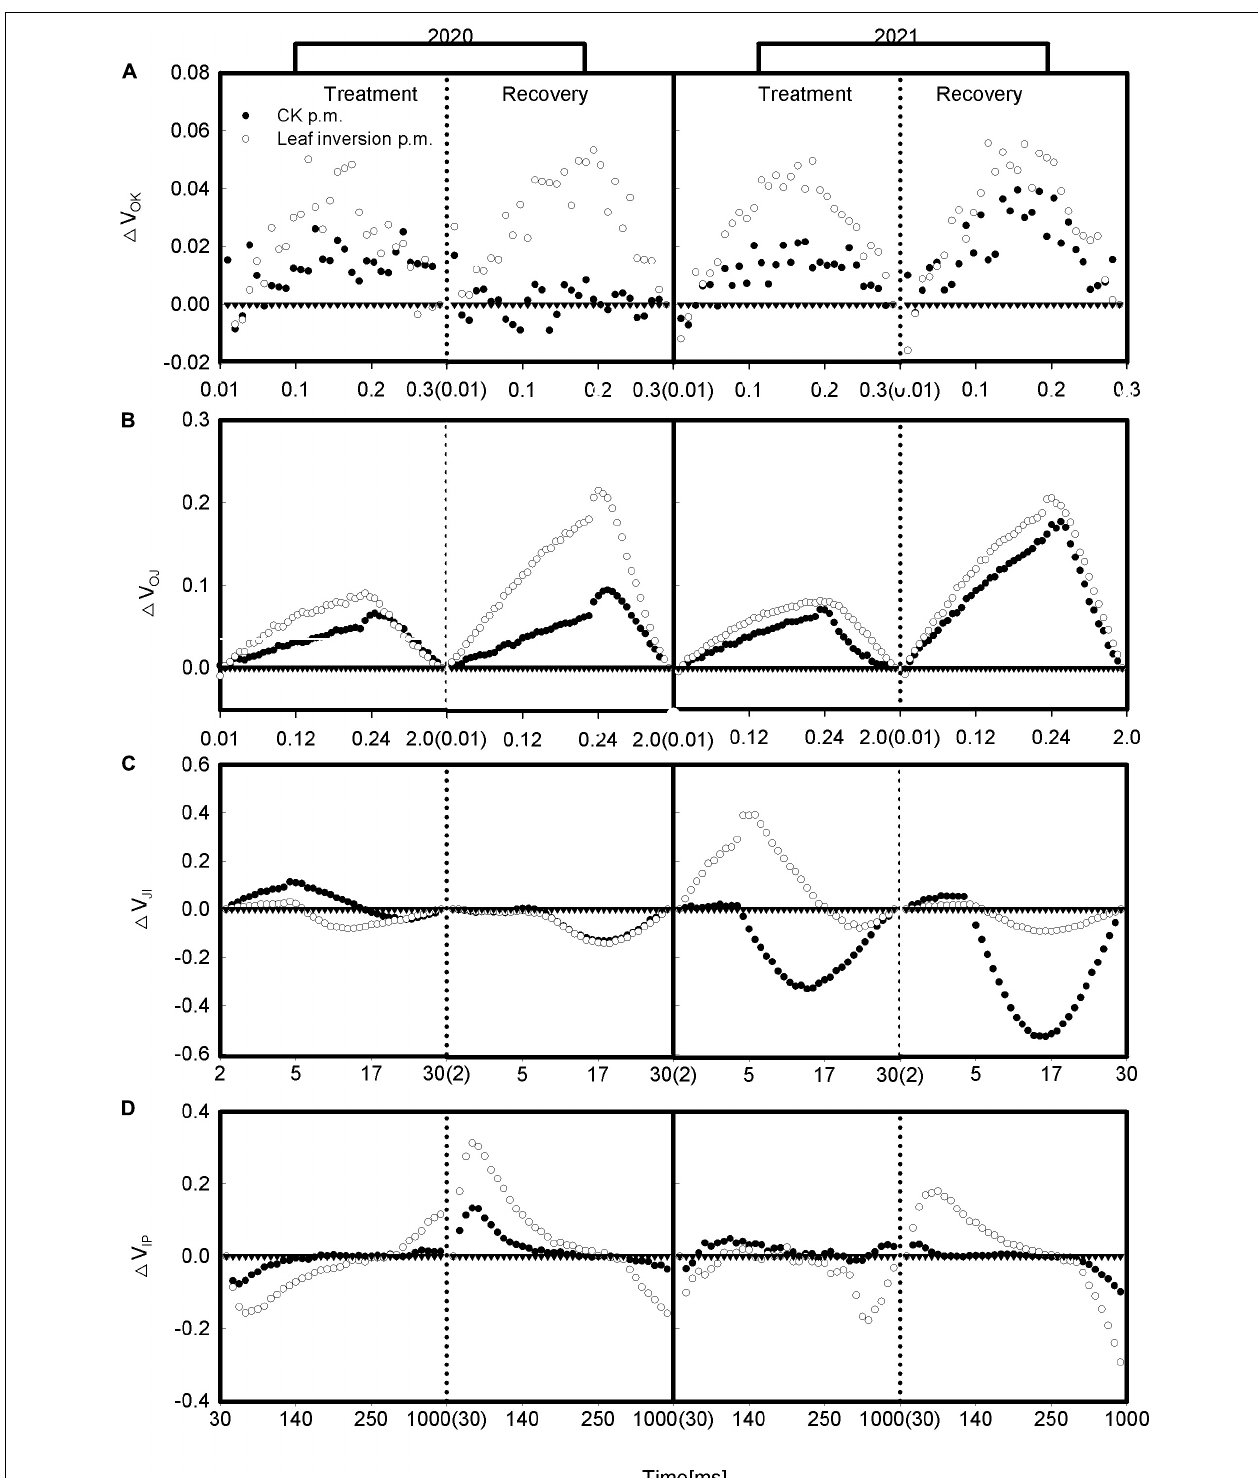
FIGURE 4 | (A–D) Double normalization between F O and F K expressed as V OK [V OK = (F t –F O )/(F K –F O )], between F O and F J expressed as V OJ [V OJ = (F t –F O )/(F J –F O )], between F O and F I expressed as V OI [V OI = (F t –F O )/(F I –F O )], between F J and F I expressed as V JI [V JI = (F t –F J )/(F I –F J )], and between F I and F P expressed as V IP [V IP = (F t –F I )/(F P –F I )]. (cid:77) V OX = V OX (measurement at 4 p.m.)–V OX (measurement at 9 a.m.). Each curve presents the average kinetics of five repetitions. The vertical dotted line separates treatment from recovery. The values in parentheses are the starting values for the graph on the right.